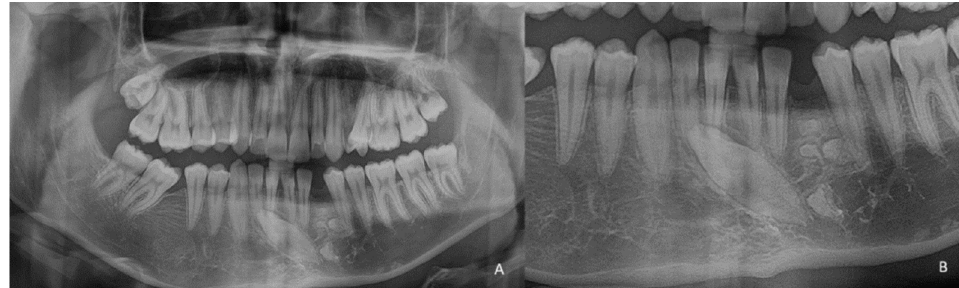
Figure 9. ( A ) Orthopanoramic image of the dental arches. The inclusion of the lower left canine, element 33, and the presence of at least four denticles are noted. The organization of a new formation is a little different than in the previous cases; ( B ) Details of the pre-operative orthopanoramic on the left. This seems less organized as can be seen in detail in ( B ); the various denticles seem less circumscribed and more scattered in the bone structure. The presence of the neoformation determined the inclusion of the tooth; there are no agenesis.